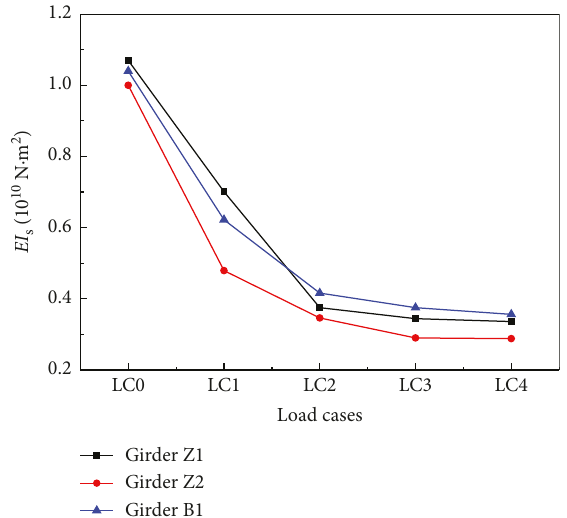
Figure 12: Equivalent flexural rigidity of three